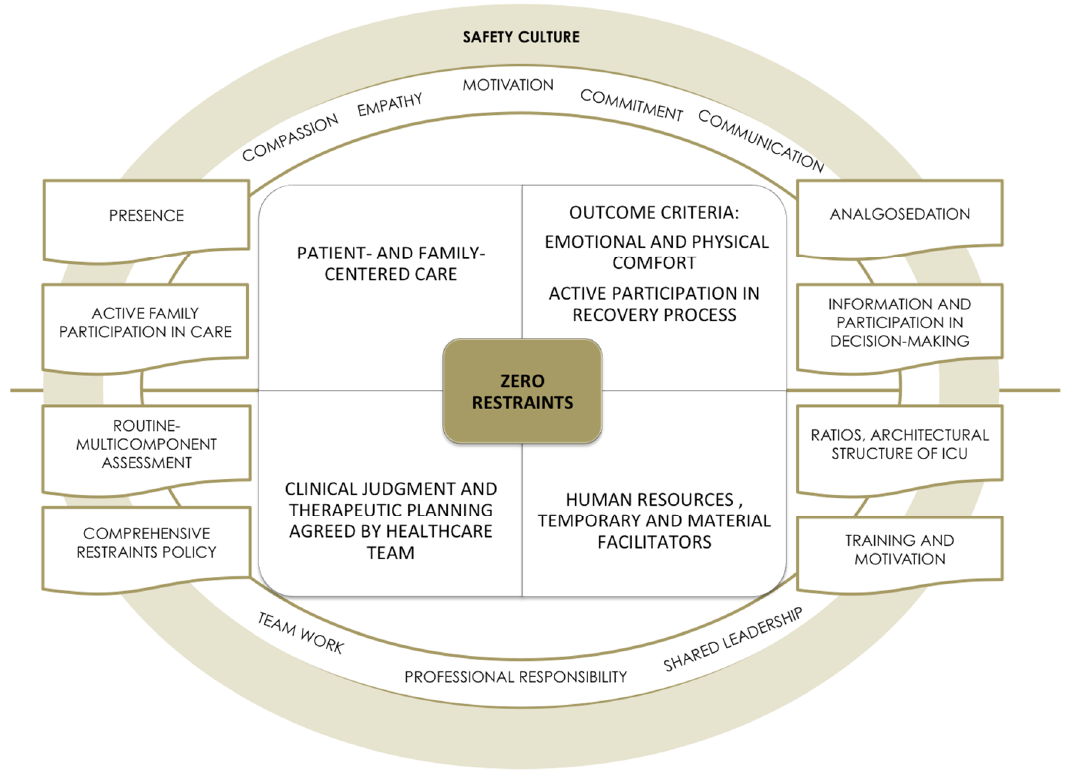
Figure 11. Work proposal under the “zero-restraints” paradigm. Abbreviations: ICU: intensive/critical care unit.